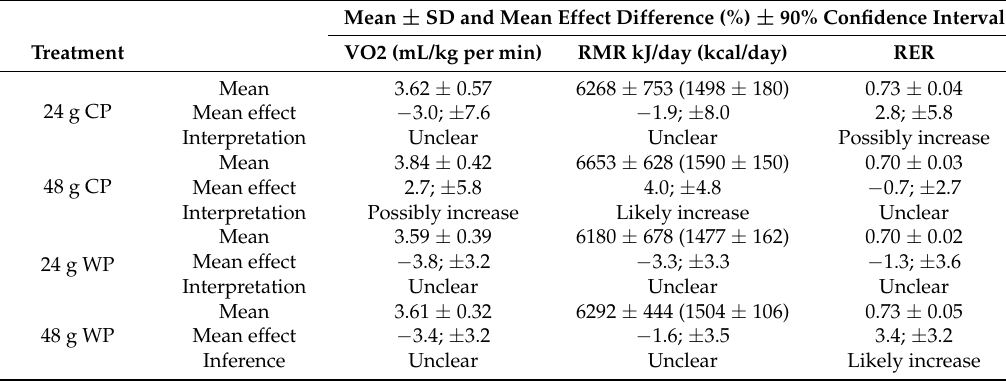
Table 1. Comparison of Proteins versus Non-Energetic Placebo on Metabolic Variables.